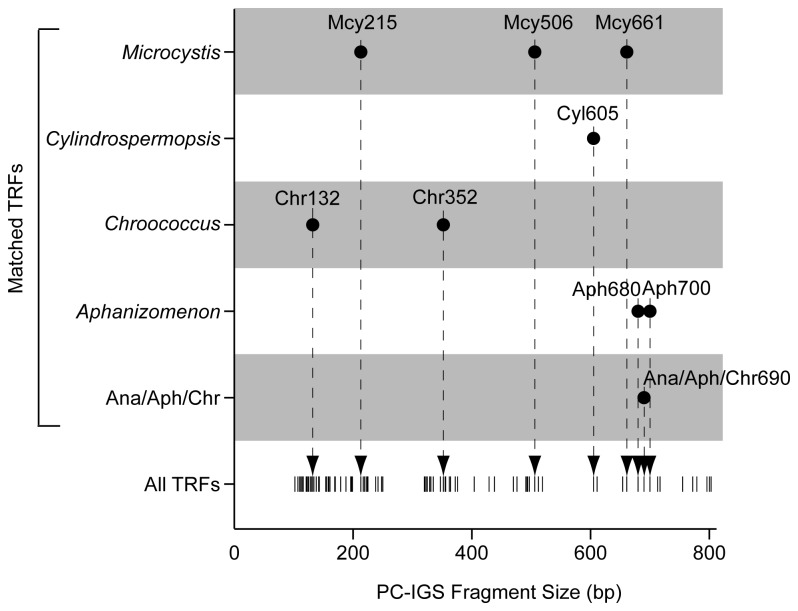
Identification of cyanobacteria represented by APISA OTU’s.Nine of the 94 unique PC-IGS terminal fragments (TRFs) detected among 197 sample could be matched by size to an in
silico MspI digestion of PC-IGS sequences previously retrieved from the same samples. These were the most abundant TRFs detected representing 87.1 ± 13.5% of the total peak heights in any given sample indicating that these are the most abundant taxa in our samples.